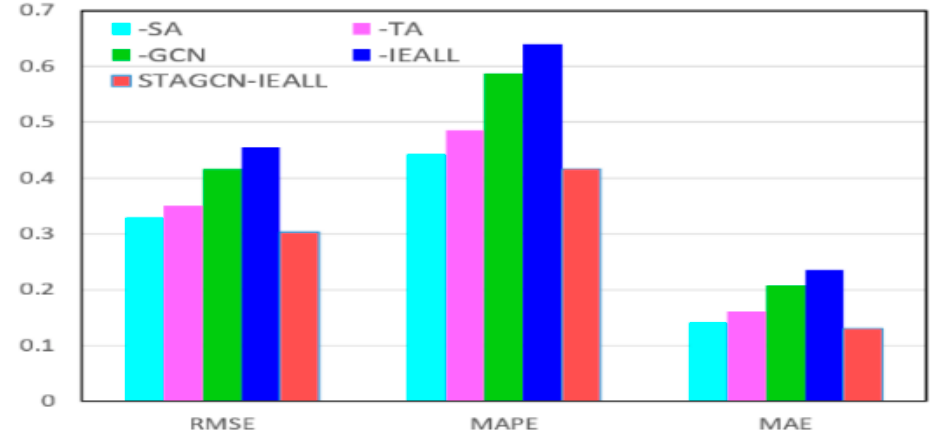
Figure 13. Comparison of model predictions of each variant.